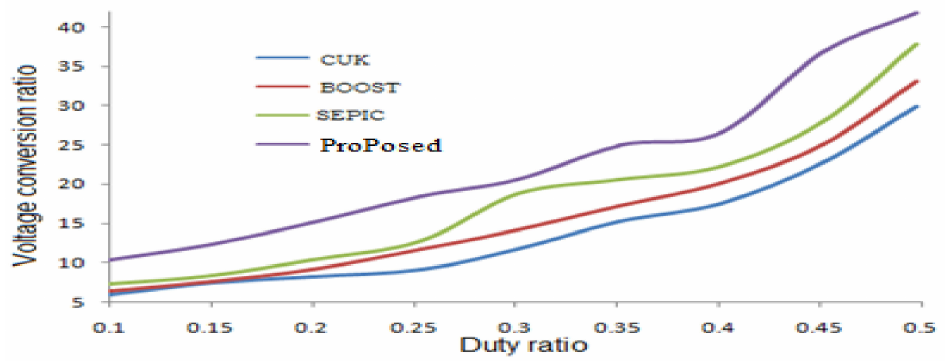
Figure 11. Voltage conversion ratio versus duty